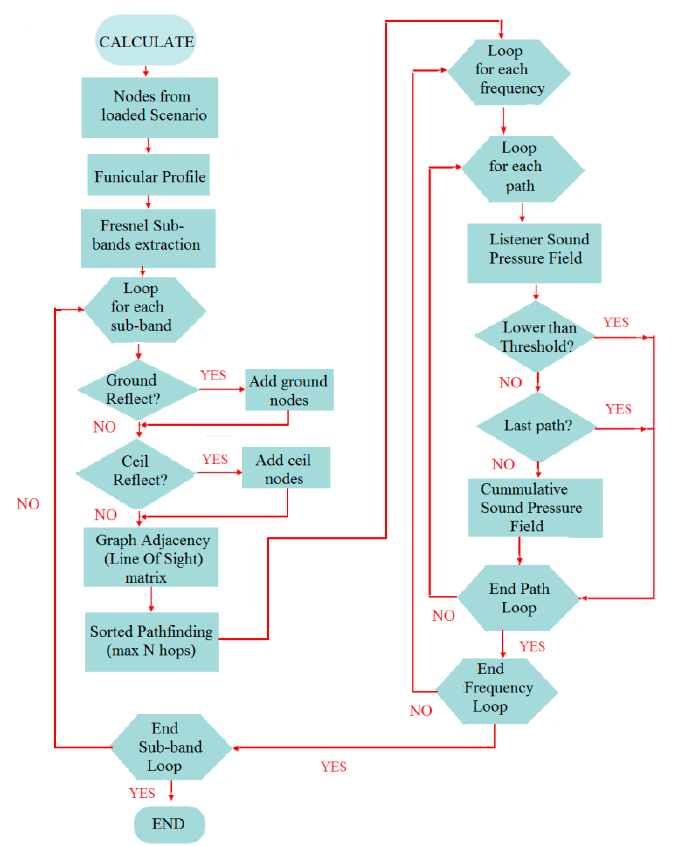
Figure 7. ‘Calculate’ subroutine flow diagram.